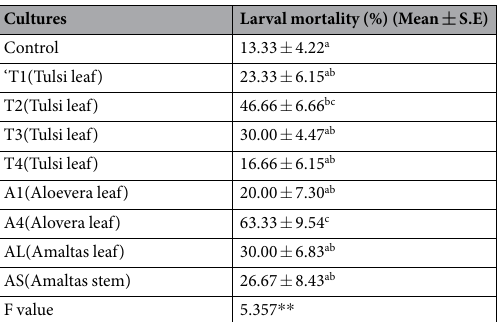
Table 1. Screening of fungi isolated from different plants for insecticidal potential against S. litura . Values are Mean ± S.E. Significance ascribed as * p < 0.05 and ** p < 0.01 (One way ANOVA). The values followed by